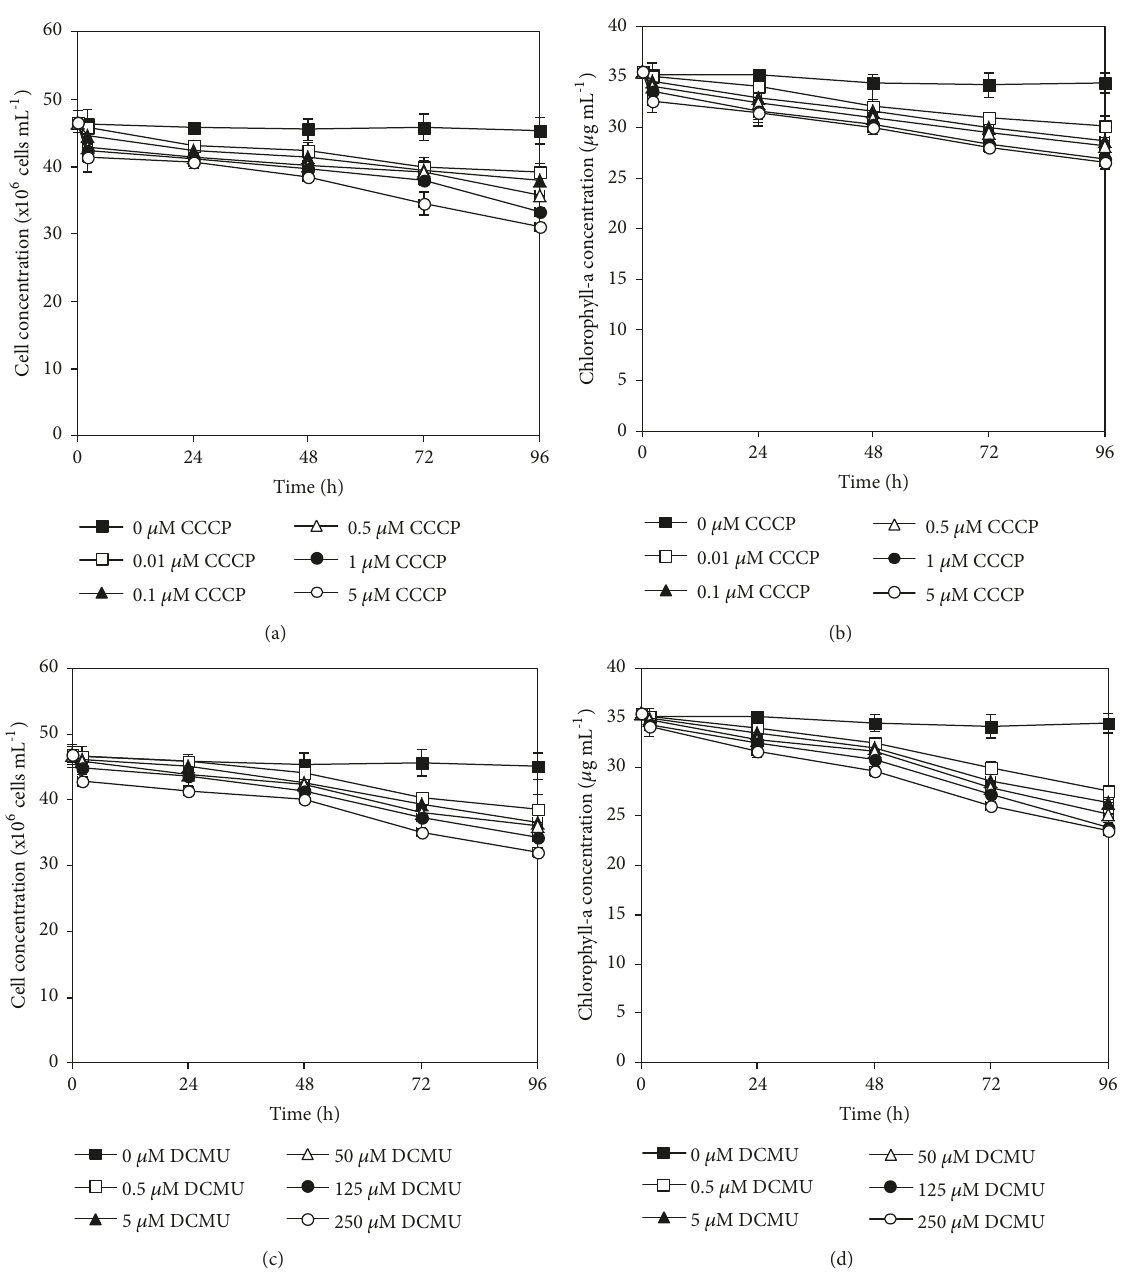
Figure 1: Effects of various concentrations of carbonyl cyanide m-chlorophenyl hydrazone (CCCP) and 3-(3,4-dichlorophenyl)-1,1- dimethylurea (DCMU) on cell concentrations (a, c) and chlorophyll-a concentrations (b, d) of Aphanothece halophytica after various incubation